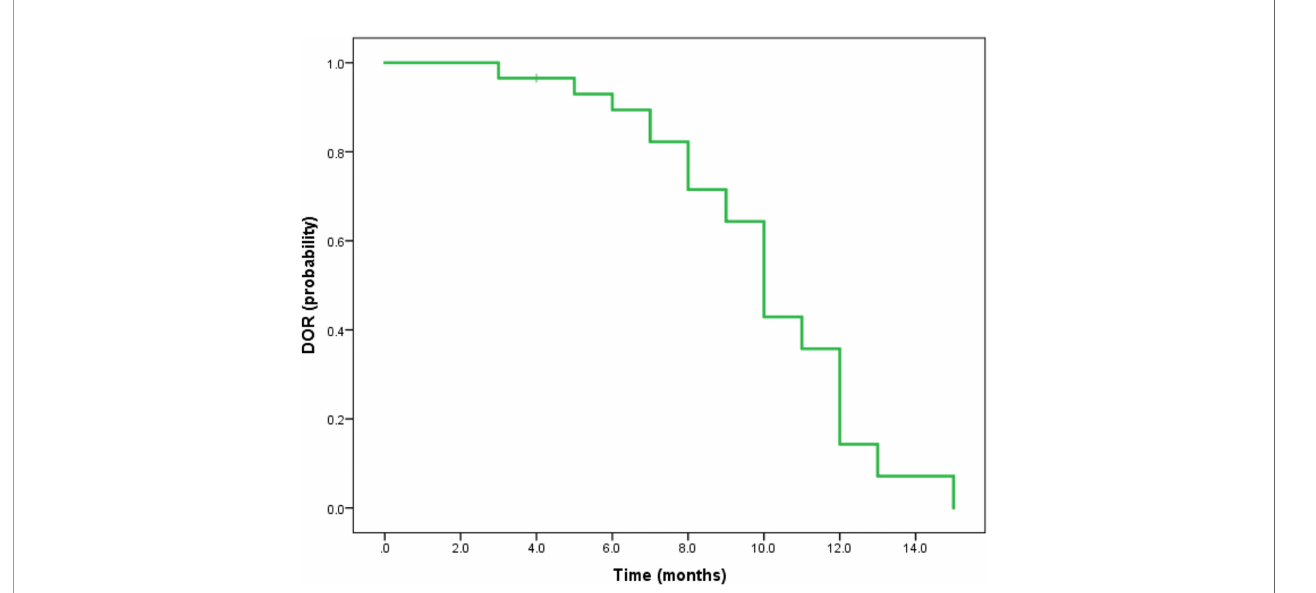
FIGURE 2 | Kaplan-Meier method-based estimate of DOR by